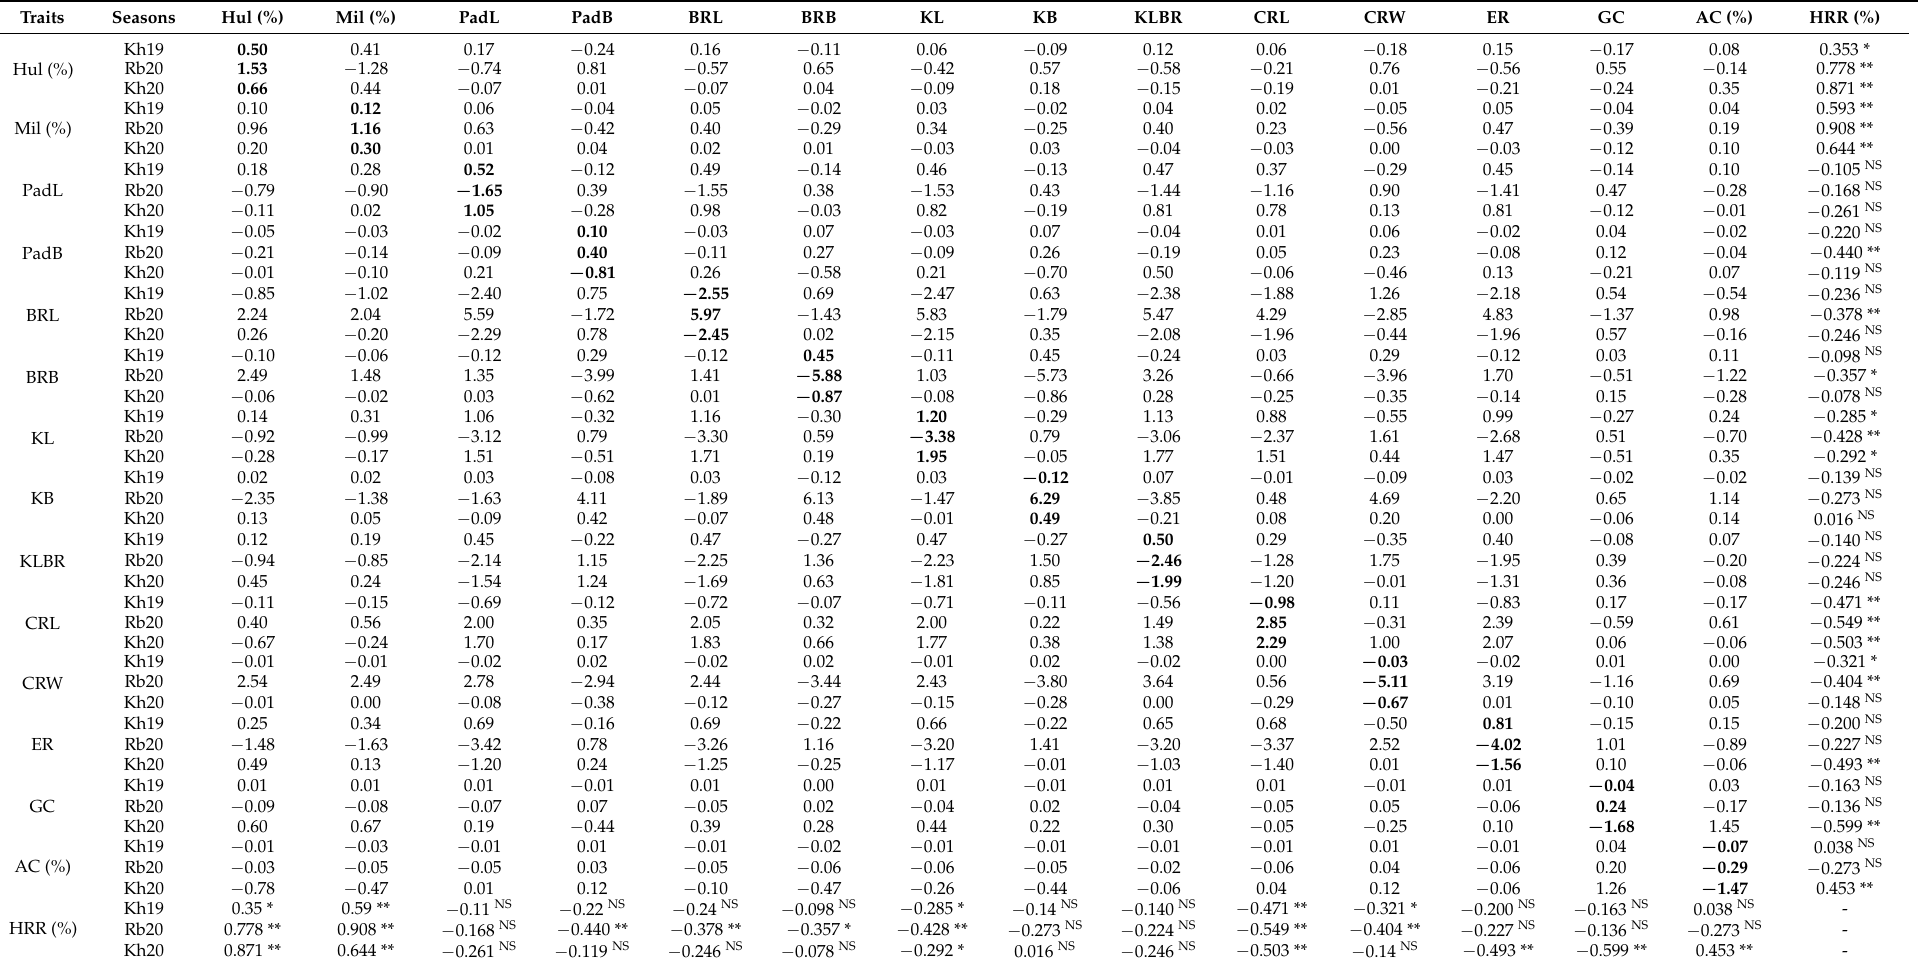
Table 6. Path coefficient analysis for the grain quality traits during all three